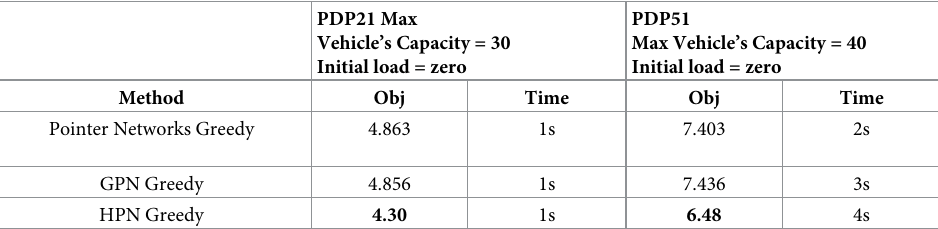
Table 3. Results on PDP21 and